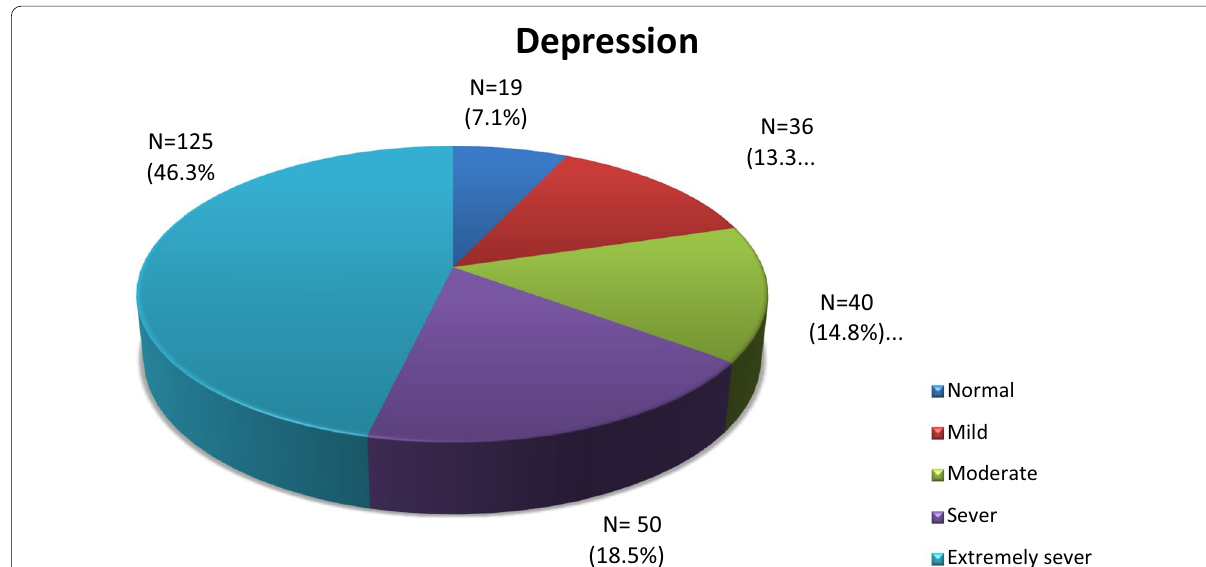
Fig. 1 Frequency of depressive symptoms according to DASS-21 questionnaire among the